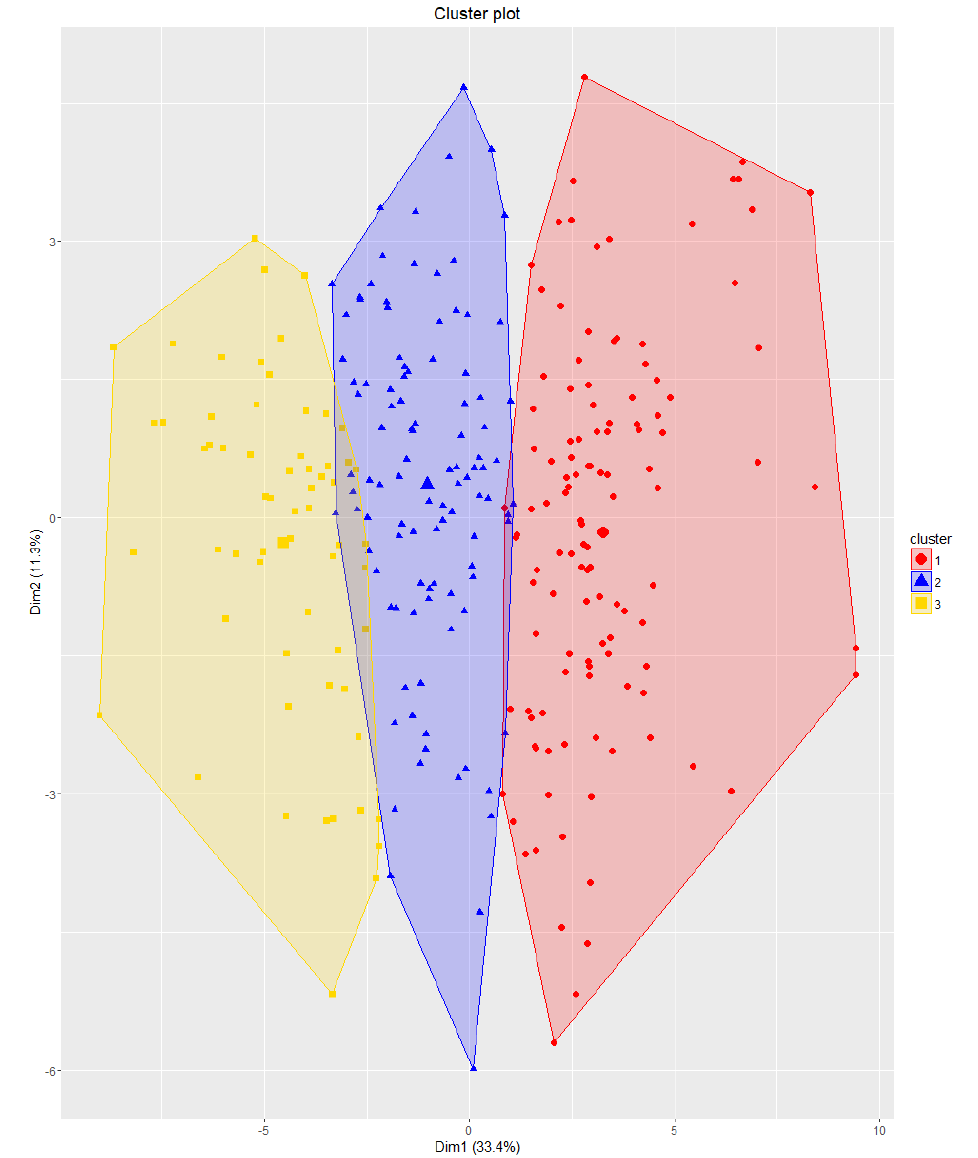
Figure 10. Cluster plot—resulting clusters identified by